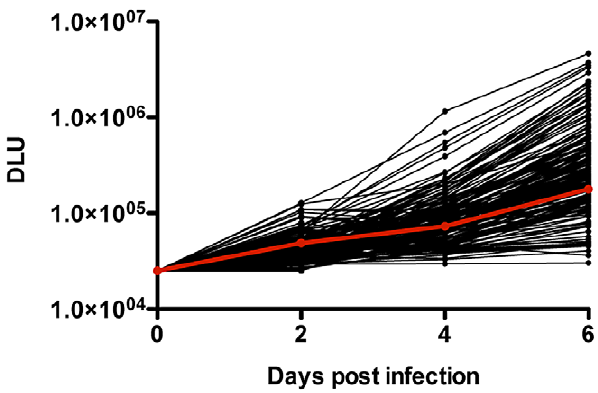
Figure 1. Insertion of the gag gene from newly infected individuals dramatically alters the replicative capacity of MJ4. In order to generate replication curves, 5 6 10 5 GXR25 cells were infected with Gag-MJ4 chimeras at an MOI of 0.05. Viral supernatants (100 m L) were collected on days 2, 4, and 6, and the amount of virus in supernatants was quantified using a radiolabeled reverse transcriptase assay. Replicative capacity scores were generated by dividing the log 10 - transformed slope of replication of each Gag-MJ4 chimera by the log 10 - transformed slope of MJ4. It is clear that the insertion of the gag gene alone can dramatically alter the in vitro RC, generating viruses with up to 1000-fold different replication curves. DLU, digital light units.